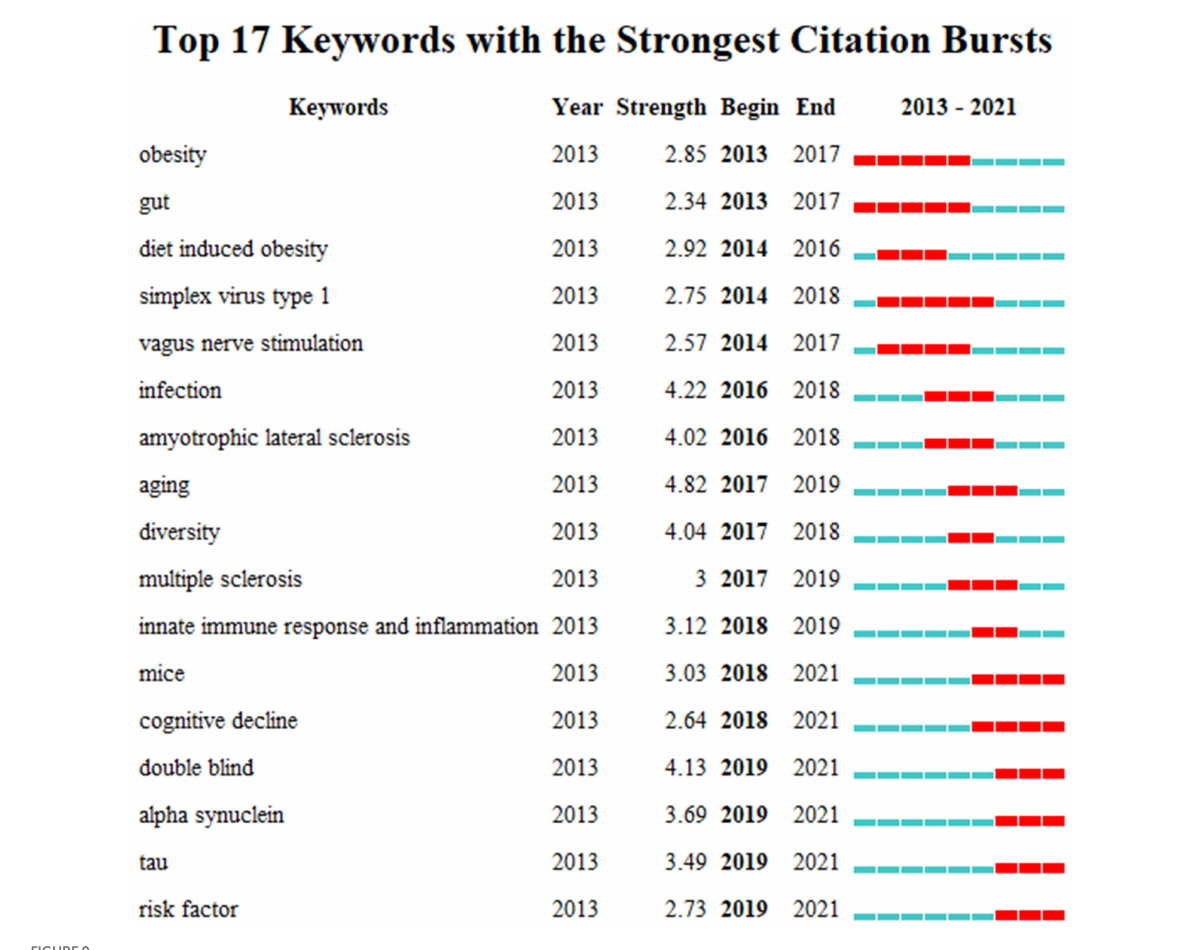
FIGURE 9 Keywords with bursts from 2013 to